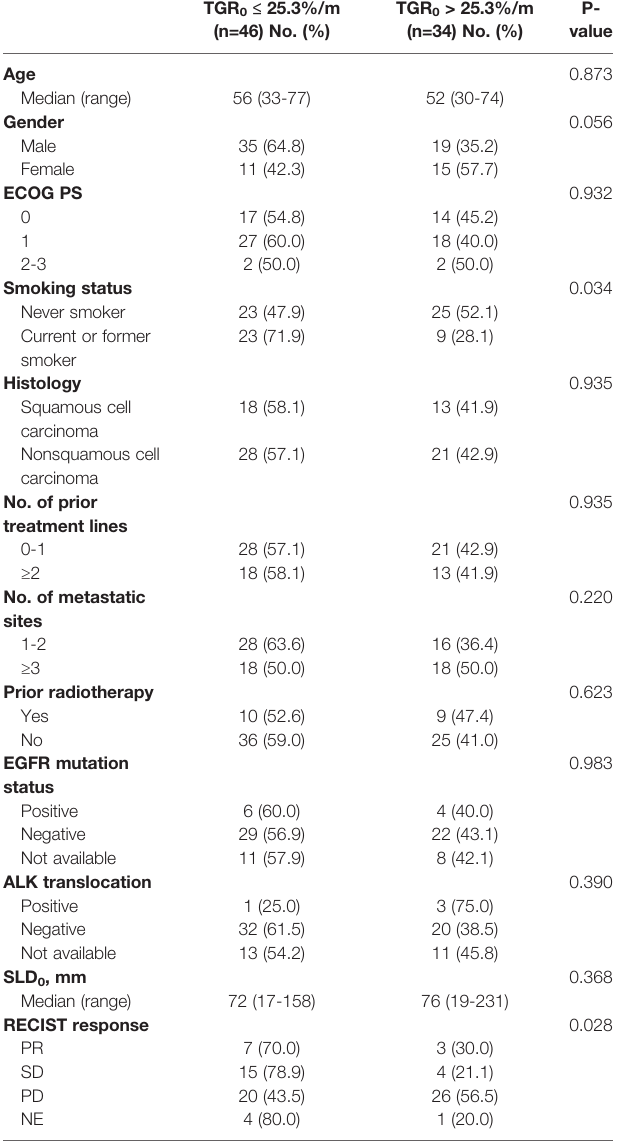
TABLE 2 | Association of TGR 0 with other parameters (n =